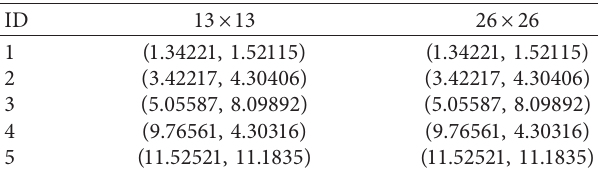
Figure 1: The network structure of the improved RDCNN by promoting YOLOv2 and v3. Table 2: The experiment effects of different activation Figure 2: The addition of batch normalization into the Darknet-19 and other convolution layers. Table 1: The anchor values of different scales proper for the ship image/video detection and classification.